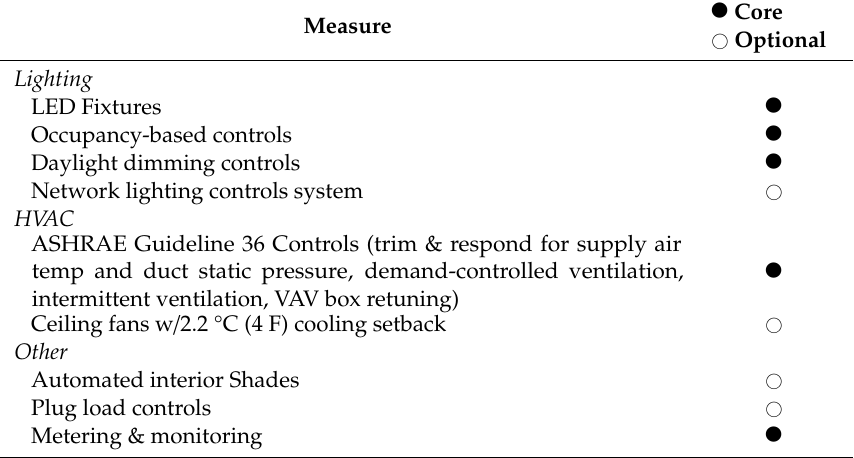
Table 1. List of measures in the tenant fit-out package.